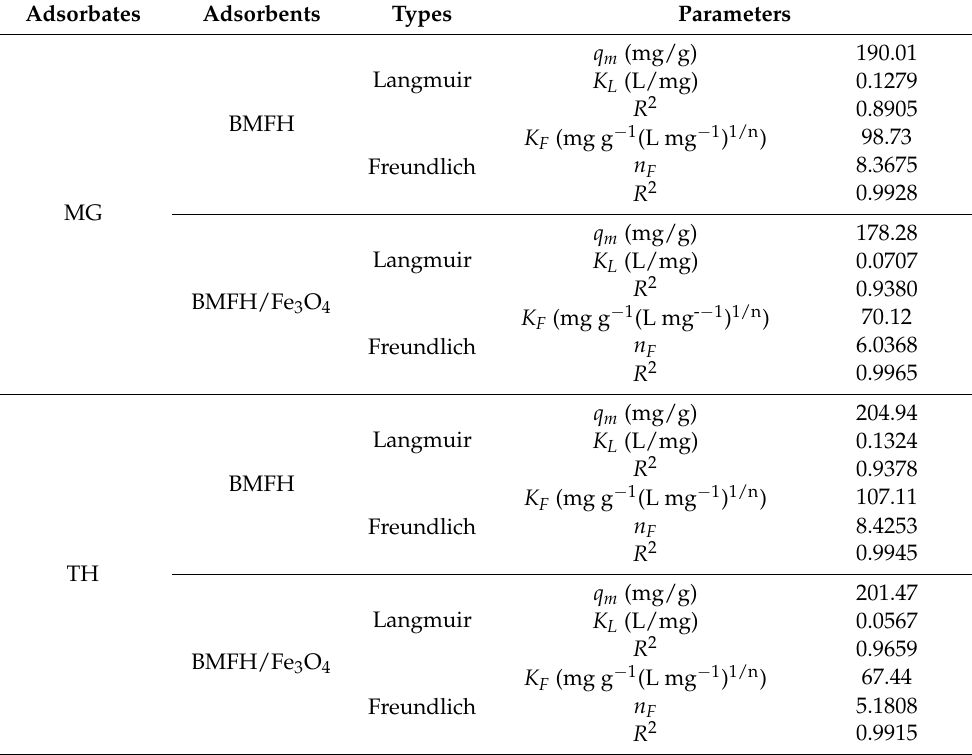
Figure 7. Langmuir and Freundlich isotherm plots of BMFH and BMFH/Fe 3 O 4 for ( A ) MG and ( B ) TH at 303 K. Table 3. Fitting parameters of adsorption isotherm models for MG and TH at 303 K.